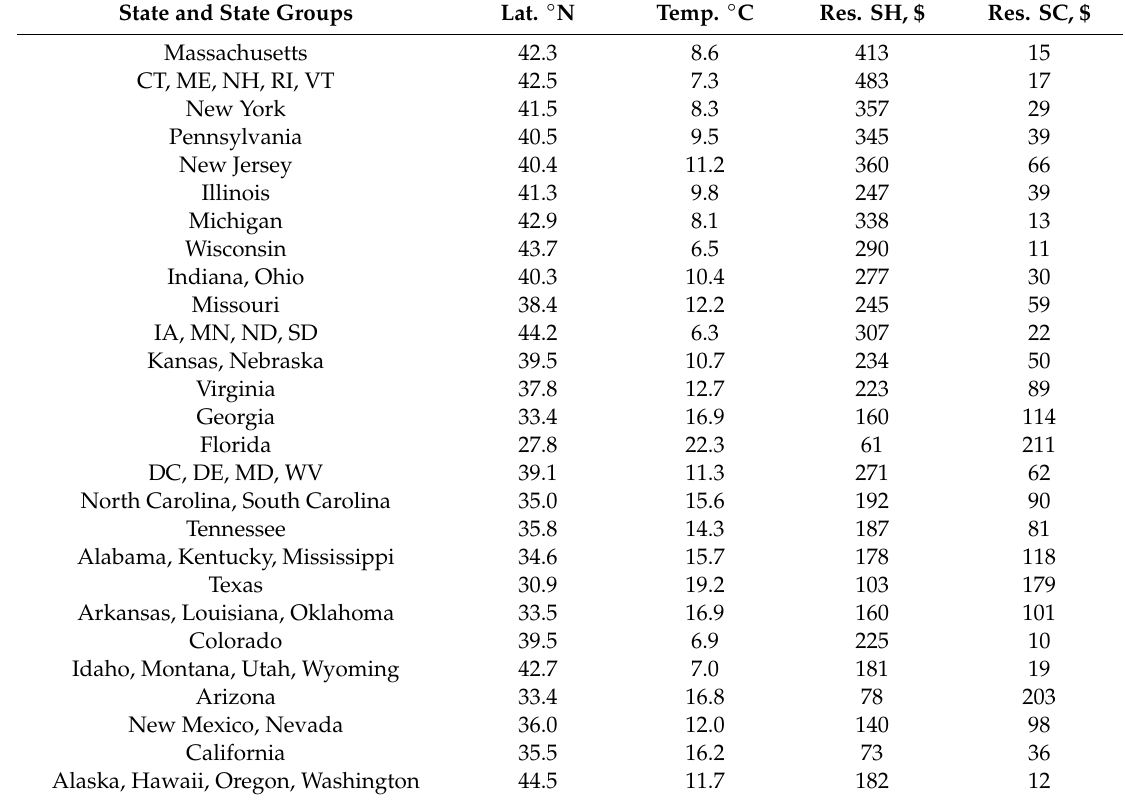
Table A1. Space heating and space cooling per capita energy expenditure, in 2010 US$, by US state and state group, for residential consumers, and the calculated latitude and 2009 temperature of the population centroid for each.